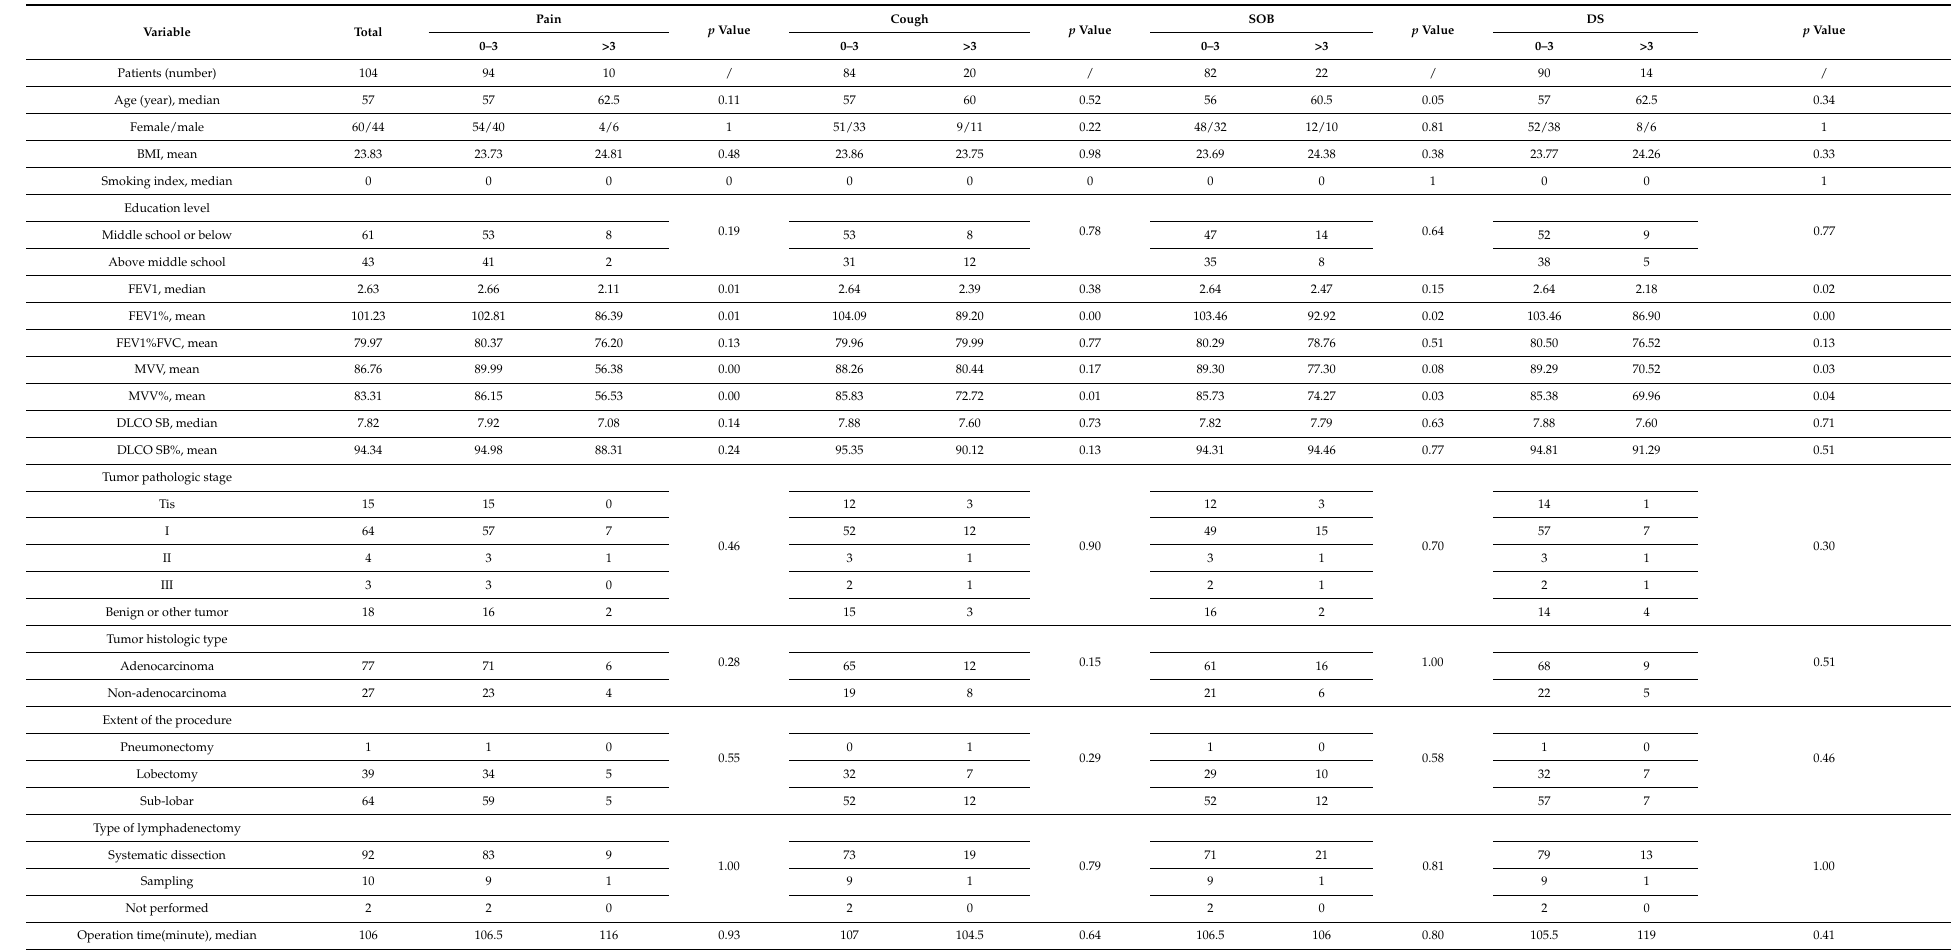
Table 1. Clinical Characteristics and PROs in fourth week after